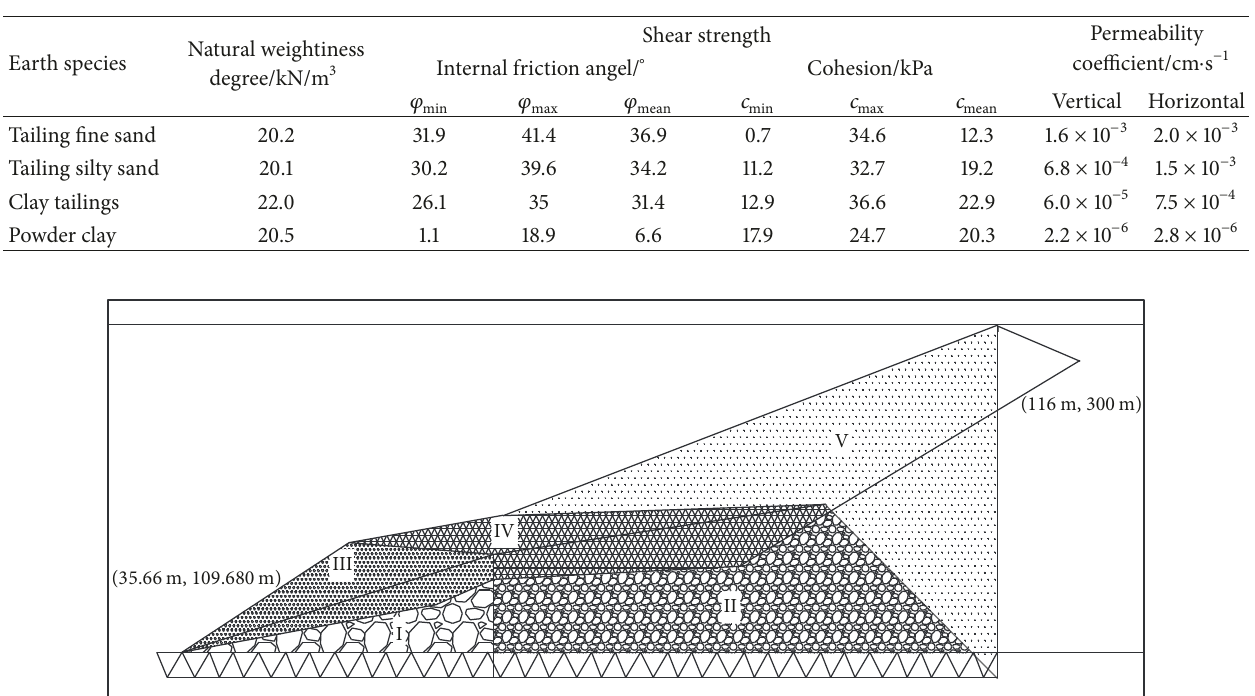
Table 3: The physical and mechanical parameters of the tailing dam.